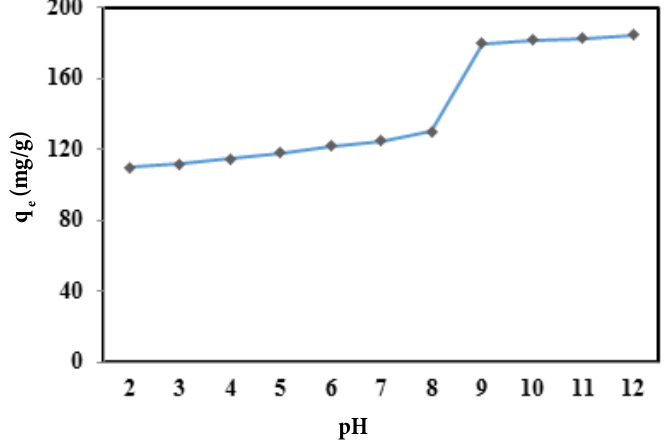
Fig. 5. Effect of pH on the adsorption of MG by the acid-thermal activated